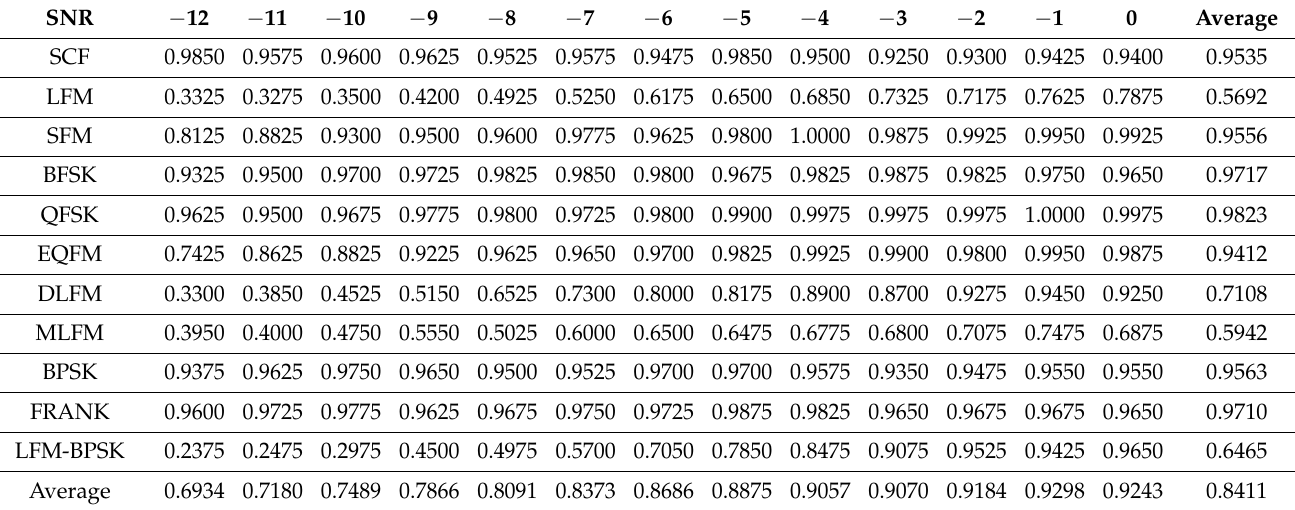
Table A23. Semi-supervised classification results with the datasets in Situation Dataset 5 ( d = 0.5 constant).